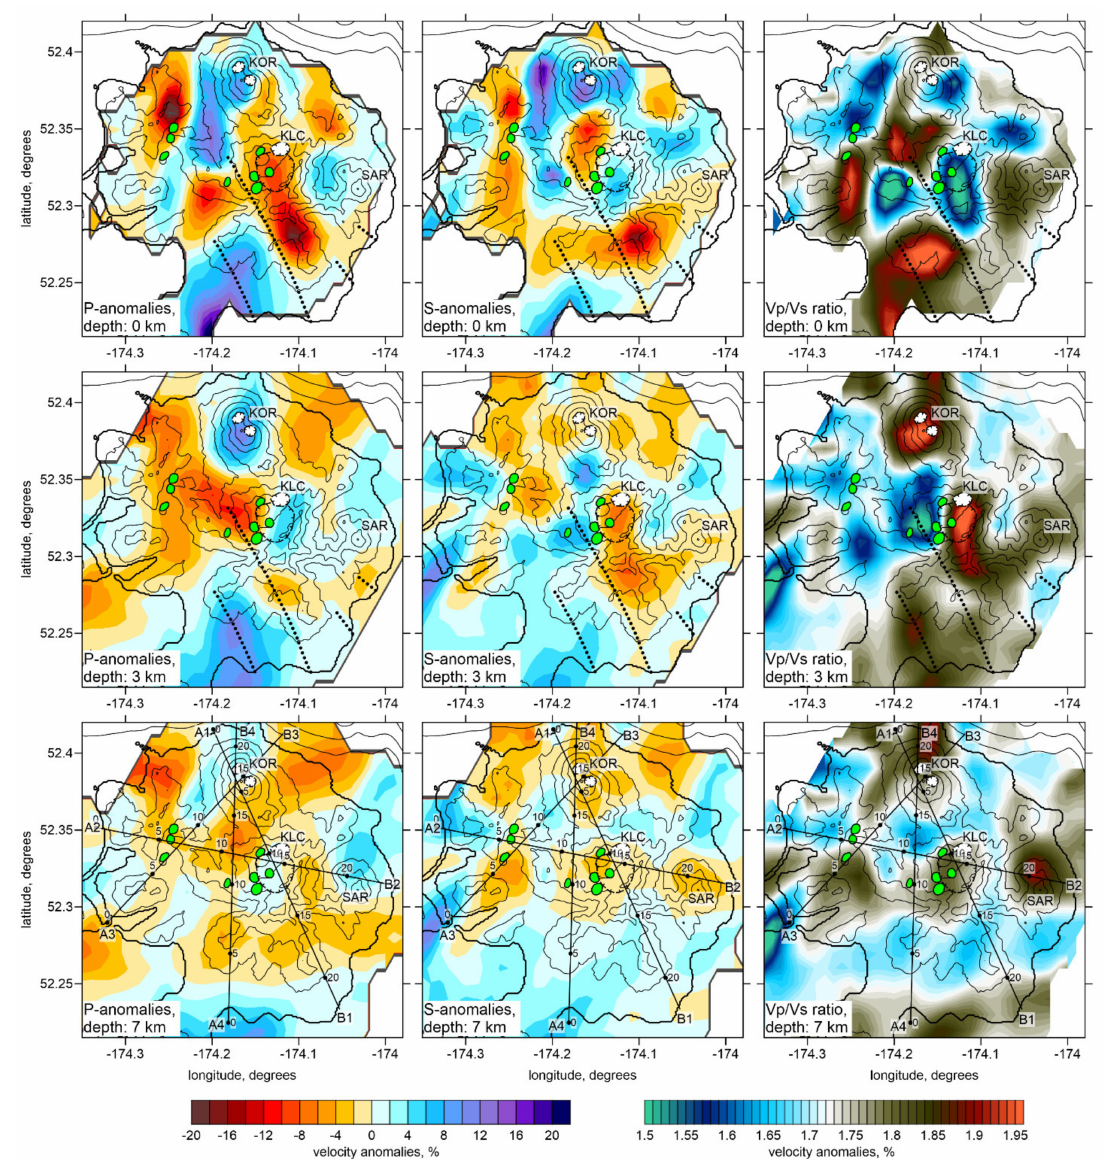
Figure 5. The resulting distributions of the dVp, dVs and Vp / Vs ratio derived from the inversion of experimental data in three horizontal sections. Green areas depict geothermal fields; white areas are the main craters of the active volcanoes. The topography is shown with contour lines, with the interval of 250 m. Volcano indications: KOR-Korovin, KLC-Kliuchef and SAR-Sarichef. Dotted lines mark the dike systems. Lines indicate the locations of four vertical sections shown in Figure